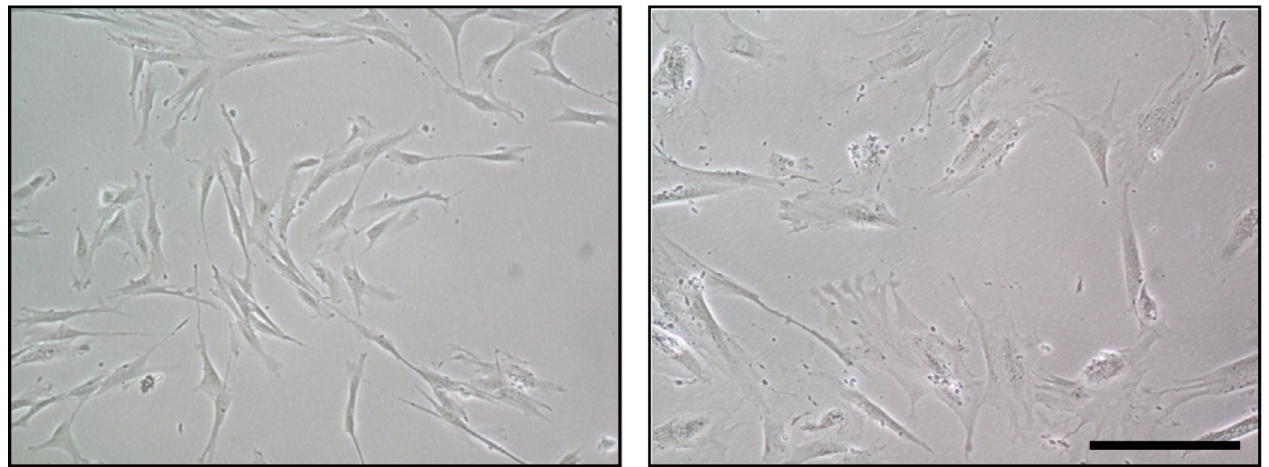
Figure 2. Morphological differences between proliferative ( left ) and senescent cells ( right ) (10x), human mesenchymal cervical stem cells (hUCESC). Scale bar: 50 μ m.